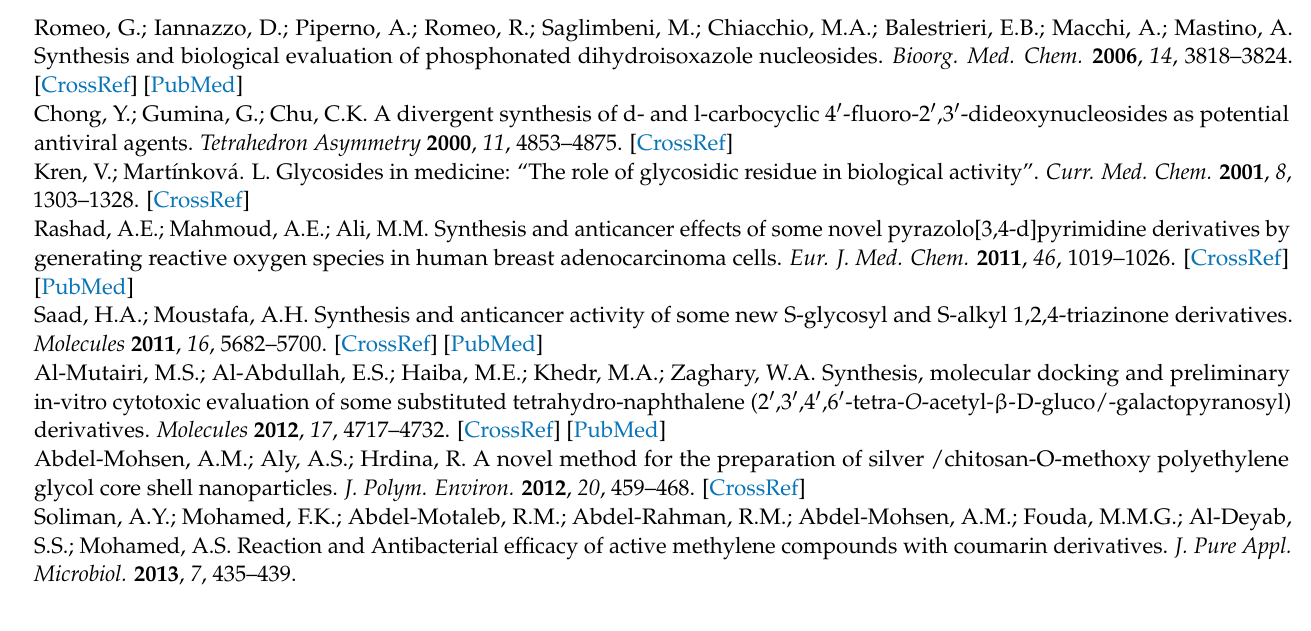
Figure S2: Illustrative figures of molecular electrostatic potentials (MESP) mapped on the electron density surface calculated by the B3LYP/6–31 + G(d) method for some selected compounds. Sym- bols are: O (red), C (gray), H (white), and N (blue); Table S1: HOMO energy, LUMO energy, and LUMO-HOMO energy gap of compounds calculated using the DFT(B3LYP)/ 6–31 + G(d) method; Table S2: Global descriptors of chemical reactivity of the structures of some studied compounds using the DFT(B3LYP)/ 6–31 + G(d)